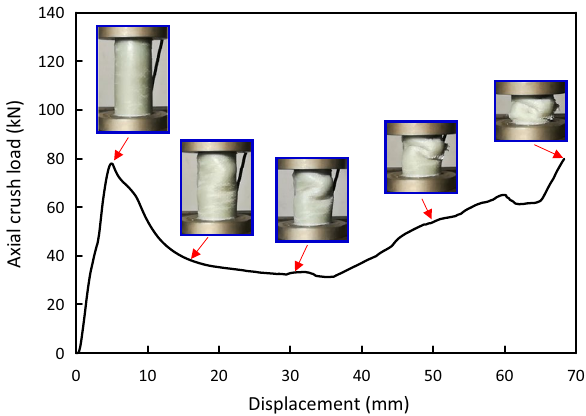
Figure 11. Load–displacement and crushing history of the Al/8G test specimen.